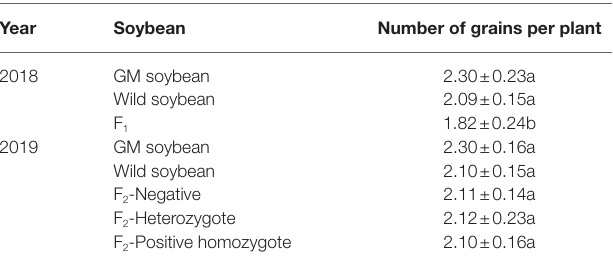
TABLE 4 | Number of full grains per pod for transgenic, wild soybeans, and hybrid